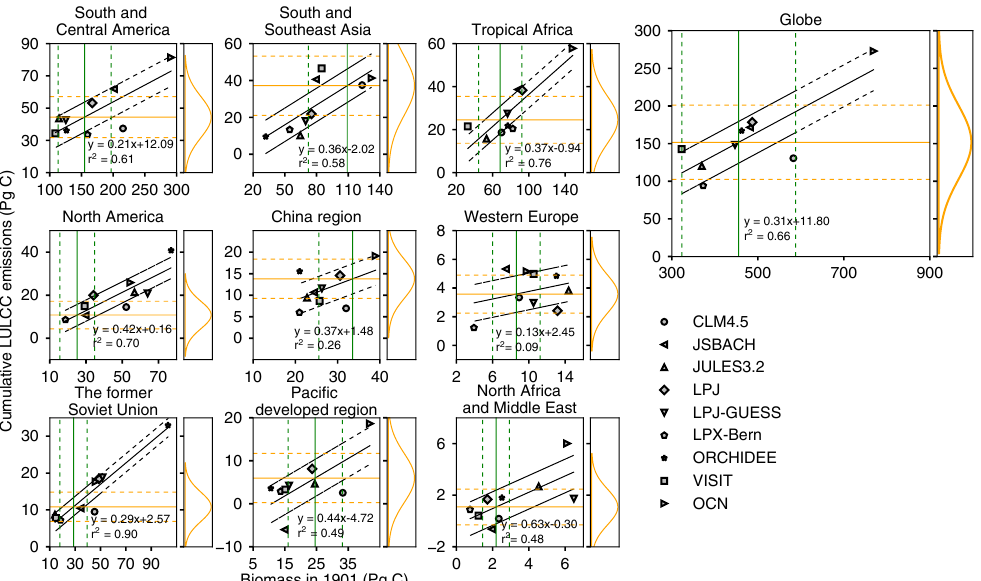
Figure 3. Relationship between biomass in 1901 and cumulative land-use and land-cover change (LULCC) emissions during 1901–2012 across the nine TRENDY-v2 models. The black solid line is the linear regression line. The vertical green solid line indicates the reconstructed biomass in 1901 from Carvalhais et al. (2014) by applying Method A (the increase in cropland in HYDE v3.1 data from forest; see Figs. S4 and S5 for the results of Method B and Method C) to define deforestation grid cells. The orange solid horizontal line indicates the cumulative LULCC emissions constrained by reconstructed biomass in 1901. Dashed lines represent 1 σ uncertainties. The probability density function of the constrained cumulative LULCC emissions is shown on the